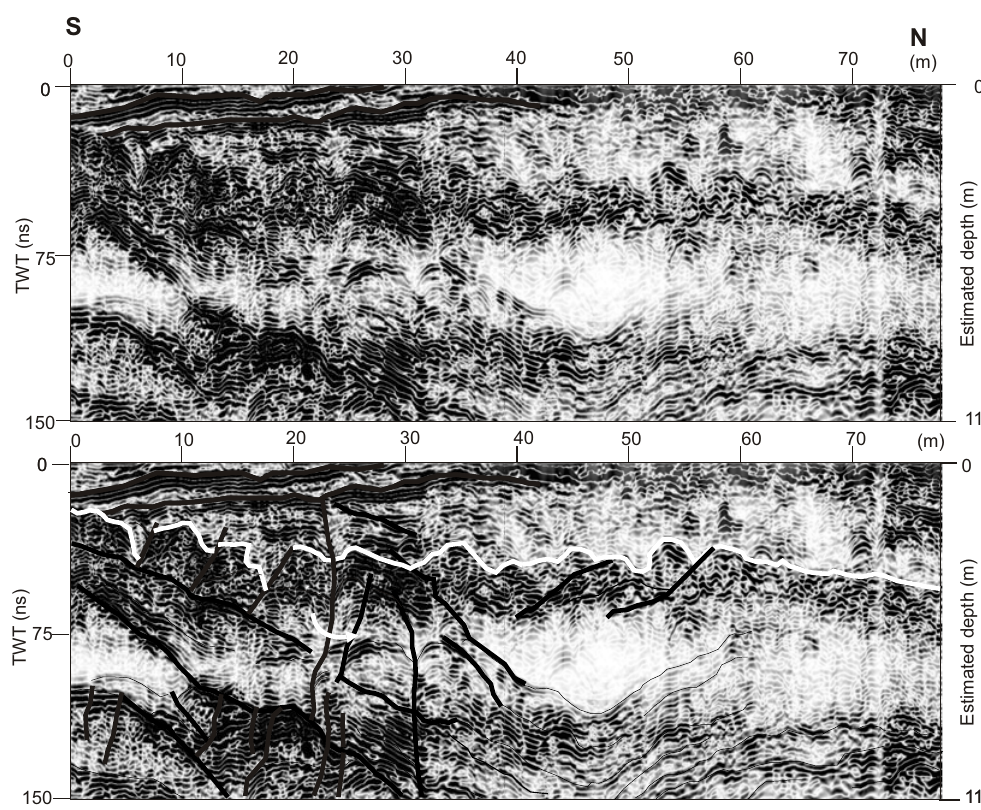
Fig. 6 – Non-annotated (upper) and interpreted (lower) GPR sections from the Atalaia Beach, where deposits of Miocene age (below white line) are strongly deformed by both folds and faults. Normal and reverse (white arrow) faults are present. Note that the degree of deformation decreases substantially upward, where only a few faults can be